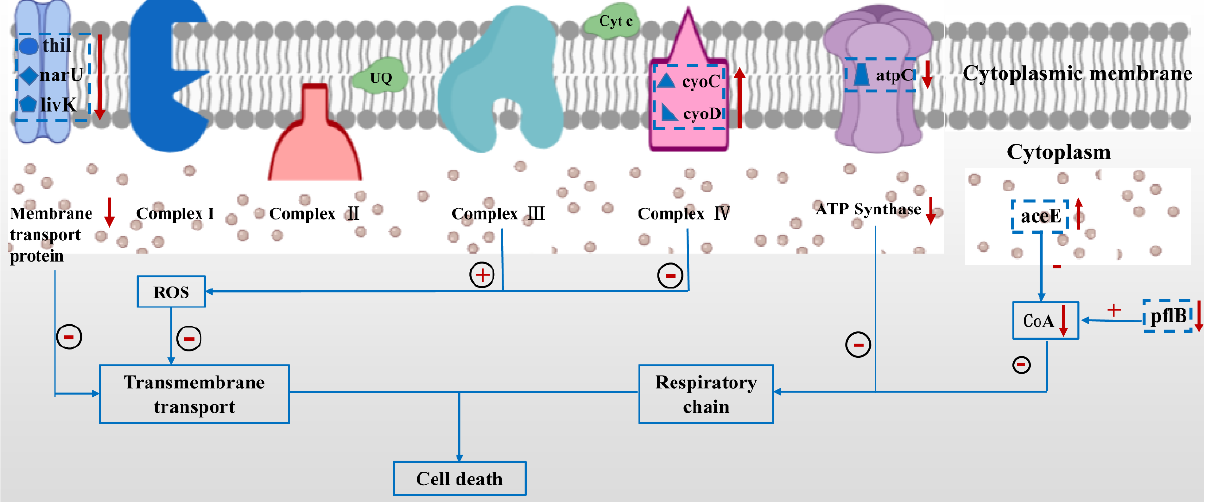
Figure 7. Schematic of the proposed antibacterial mechanism of PDA-rGO/BiVO 4 against E. coli. The up/down arrow indicates an increase/decrease in expression, the plus/minus sign indicates a positive/negative effect.